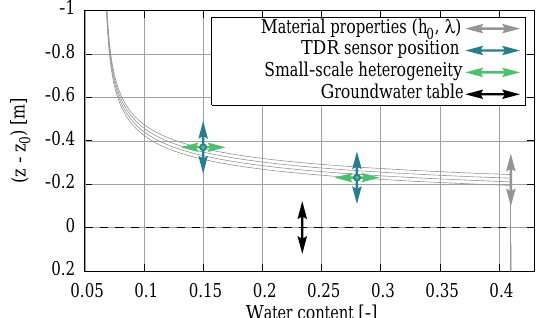
Figure 9. The estimation of uncertain model components can lead to correlated estimated parameters, e.g., as an incorrect position of the groundwater table ( z 0 ) can be compensated by changing h 0 and λ during static phases. During transient phases, however, the com- ponents have distinct effects, e.g., as λ also changes the conductivity function. Hence, the ability of the parameter estimation algorithm to separate these uncertainties depends on the available measure- ment data. Also, the more sensors are available, the fewer uncertain model components can be compensated simultaneously by the pa- rameterization.